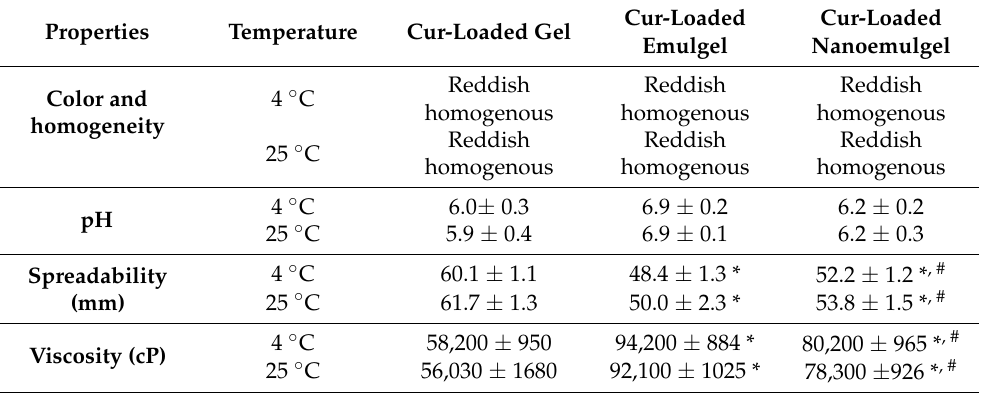
Table 4. Physical characterization of Cur-loaded formulations following 3 months storage at a relative humidity of 60% and temperature of 4 ◦ C.